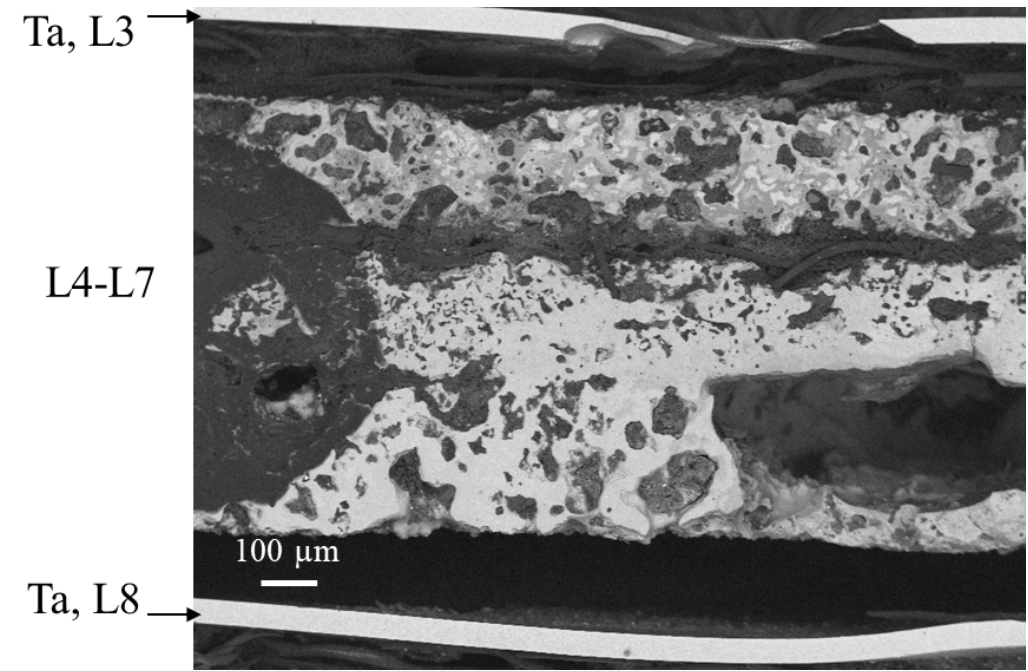
Figure 10. The cross section of burned sample formed in Set 2 illustrates the absence of joining between Ta (L3 and L8) and combustion products formed in layers L4–L7.